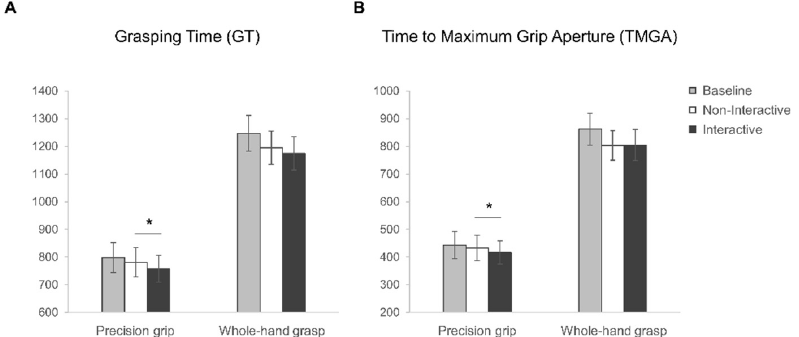
Figure 5. Kinematic results. Graphical representation of ( A ) Grasping Time (GT) and ( B ) Time to Maximum Grip Aperture (TMGA) for precision grip (PG) and whole-hand grasp (WHG) actions performed in the Baseline (grey), Non-Interactive (white) and Interactive (black) conditions. The error bars represent standard error of the mean. Asterisks indicate significant differences ( p < 0.05) between conditions (planned contrasts).